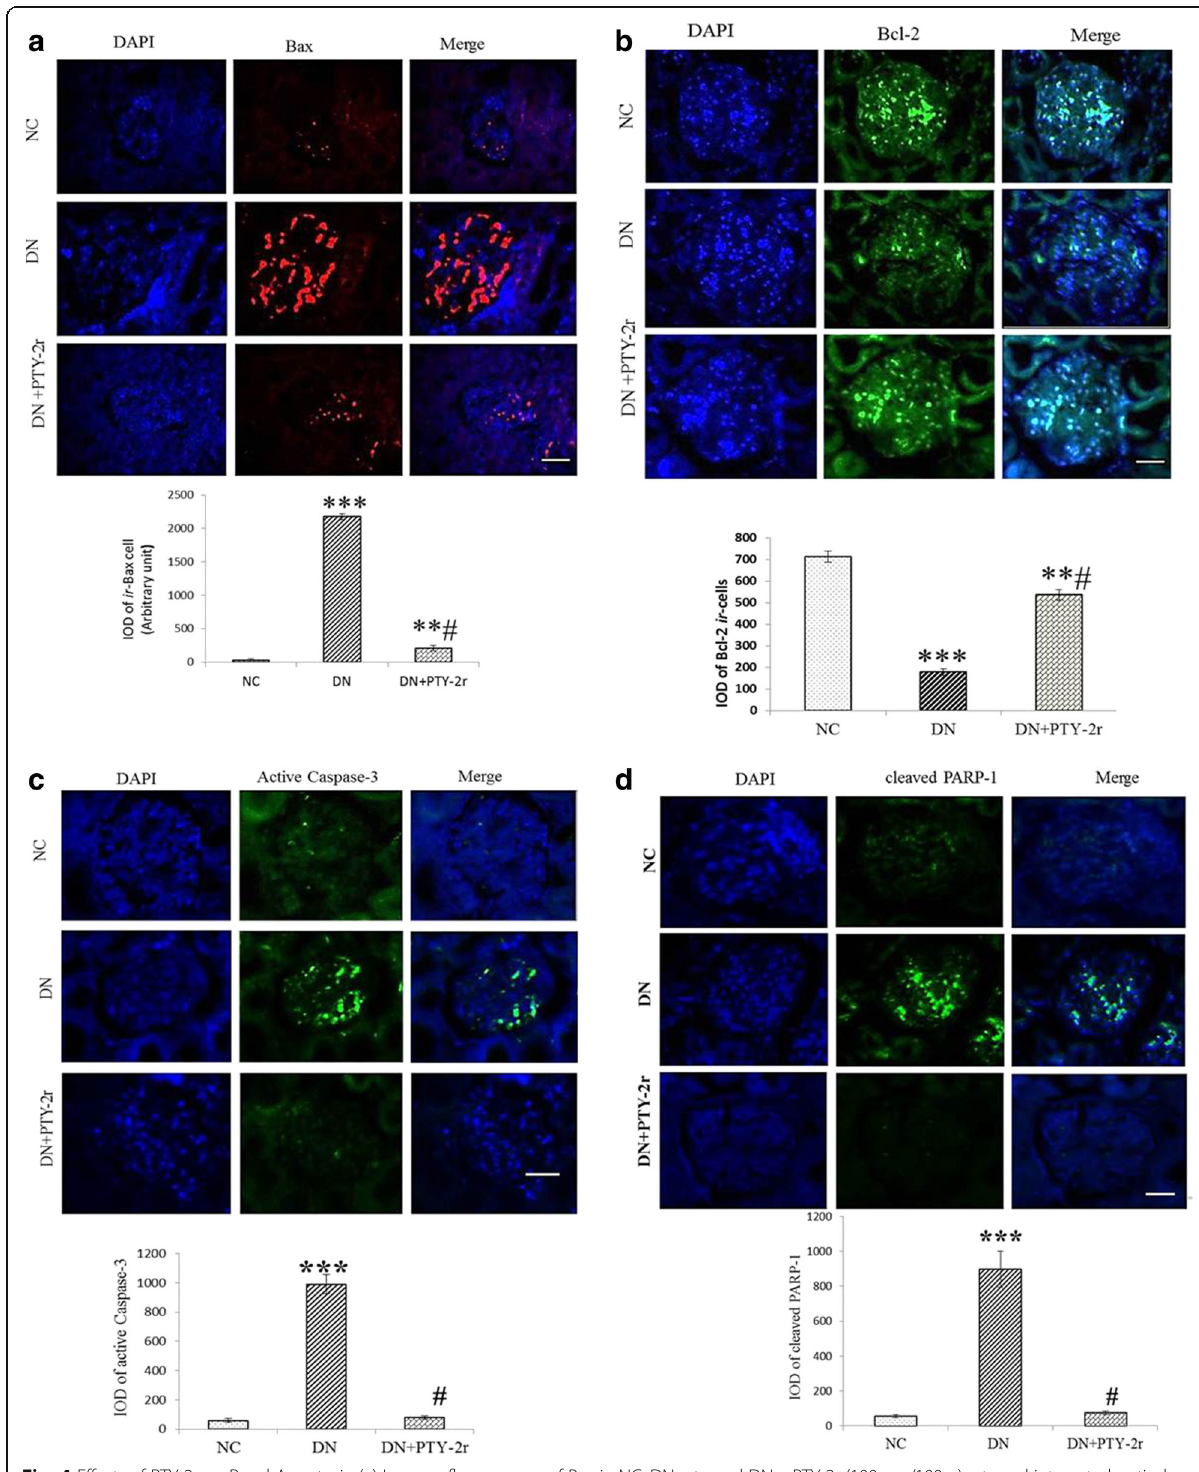
Fig. 4 Effects of PTY-2r on Renal Apoptosis: ( a ) Immunofluorescence of Bax in NC, DN rats, and DN+PTY-2r (100 mg/100 g) rats and integrated optical density (IOD) of ir - Bax cells. ( b ) Immunofluorescence of Bcl-2 in NC, DN rats, and DN+PTY-2r (100 mg/100 g) rats and integrated optical density (IOD) ( c ) Immunofluorescence of active Caspase-3 in NC, DN rats, and DN+PTY-2r (100 mg/100 g) rats and integrated optical density (IOD). d Immunofluorescence of cleaved PARP-1 in NC, DN rats, and DN+PTY-2r (100 mg/100 g) rats and integrated optical density (IOD). Scale bar, 50 μ m. All data presented in mean ±SD, ( n =6 in each group). *** p <0.001, ** p <0.05 compared with group-1; # p <0.001 compared with